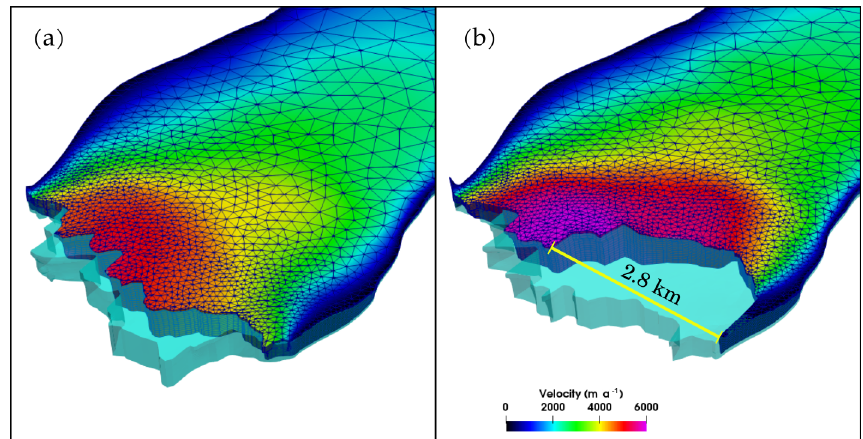
Figure 5. (a) Typical seasonal range in terminus position for control simulation (present-day forcing). (b) Collapse of the southern side of the terminus in Run MD2 (distributed melting × 2) prior to simulation break